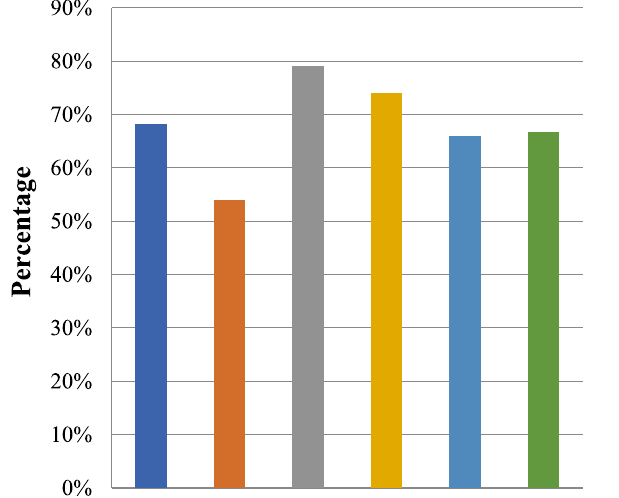
Fig. 1 Participants’ average compliance rates in CSPS dimensions and total CSPS